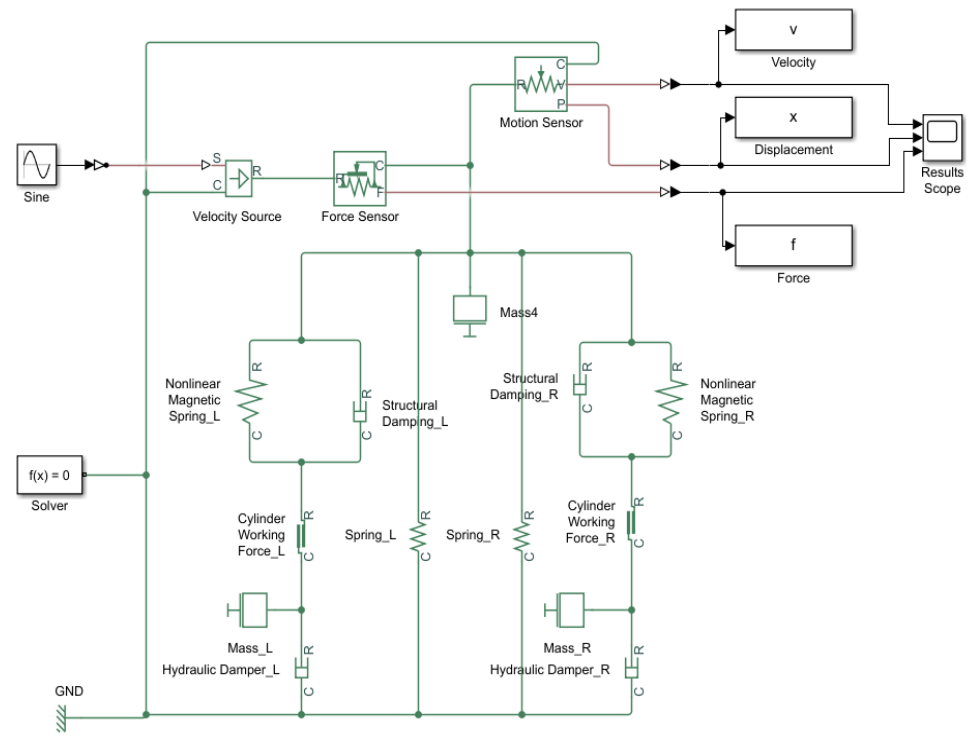
Figure 7. Simscape model of the VEAM.